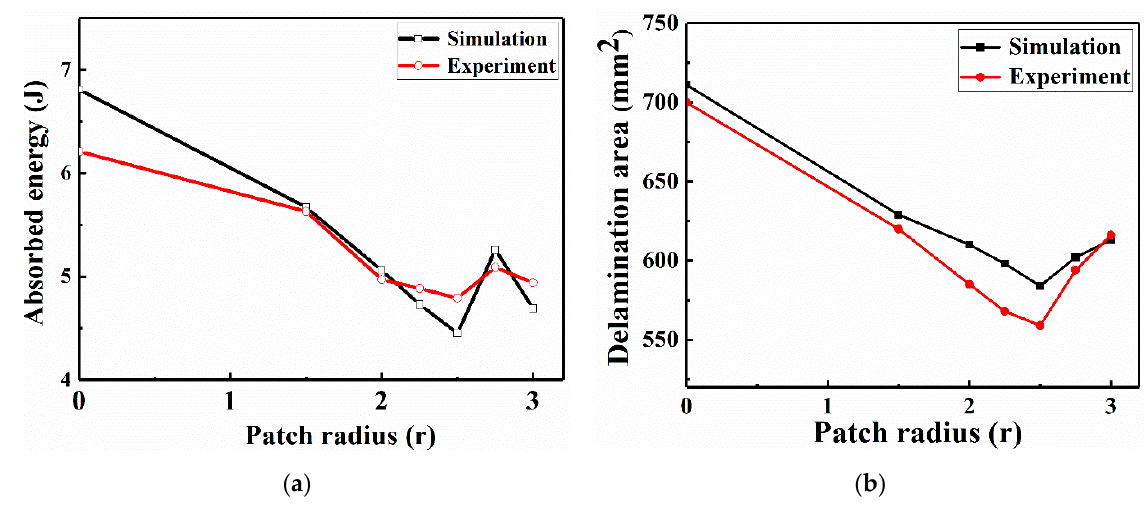
Figure 16. Numerical and experimental curves of the specimens repaired with patches of various sizes: ( a ) absorbed energy and ( b ) delamination area.